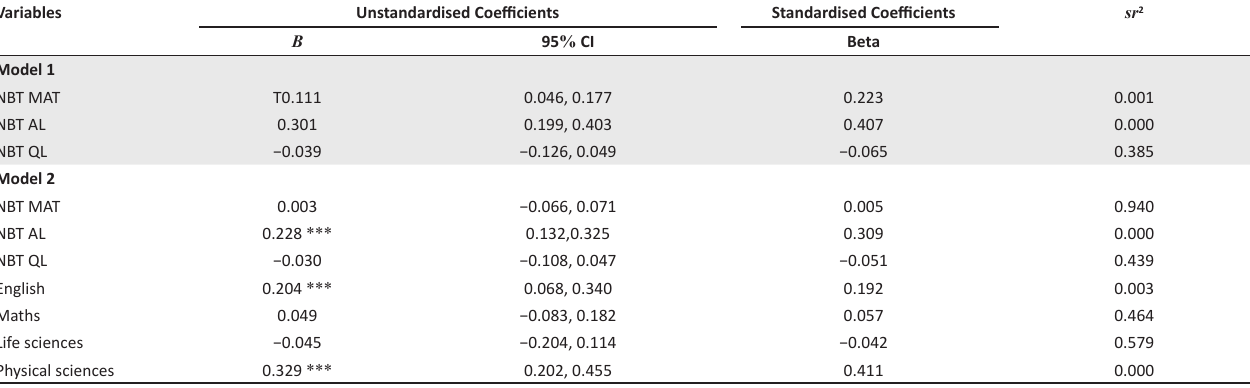
TABLE 5: Regression models of predictors of success ( N = 216).